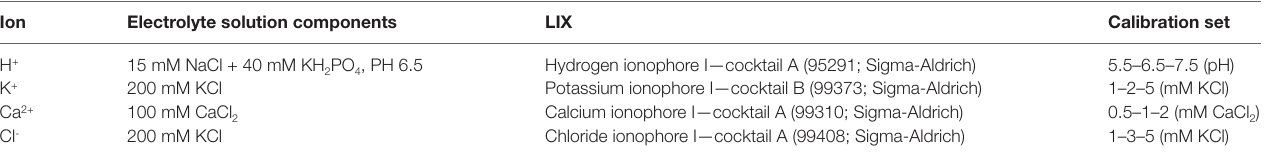
TaBLe 1 | Fabrication details for the ion-selective microelectrodes containing liquid ionic exchanger (LIX) used in the study. Ion electrolyte solution components LIX Calibration